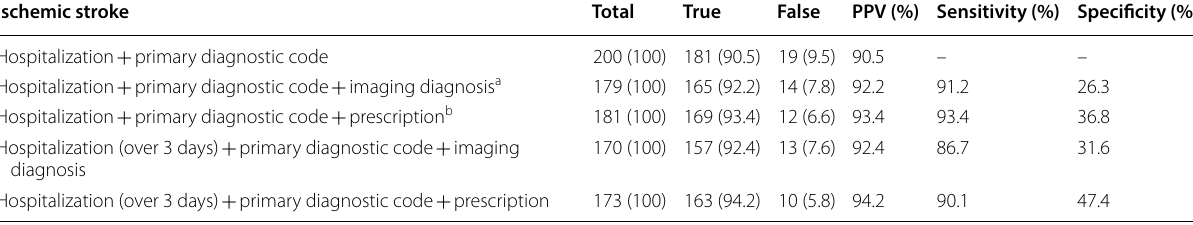
Table 4 Validation of diagnostic codes for